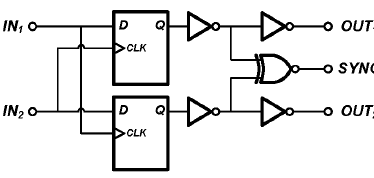
Figure 15. Block diagram of the BBPD, used to detect the phase difference of 2 input signals.